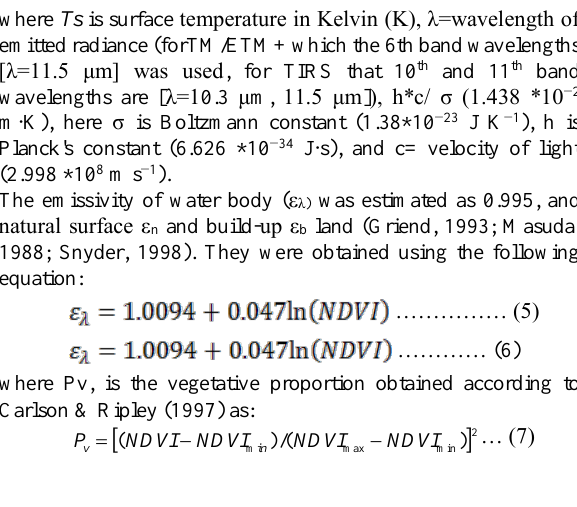
Figure 2. Normal probability plot between observed air temperature and estimated air